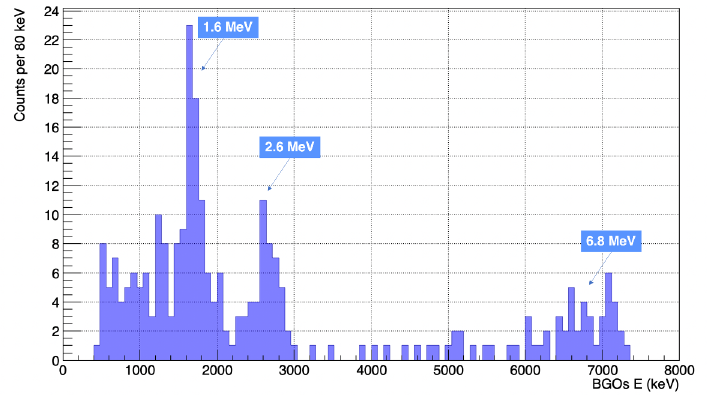
Figure 4. BGO spectrum gated on the events of the BGO - Si time di ff erence peak corresponding to the recoil ToF. The γ -rays of the 20 Ne 11.09 MeV level decay cascade can be clearly seen at 1.633, 2.613, and 6.841